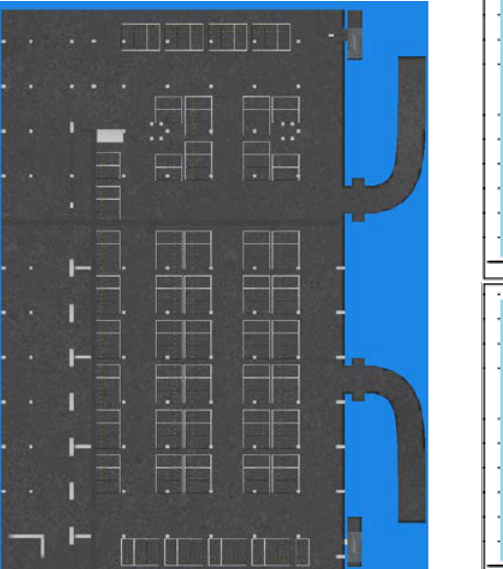
(c) Figure 20. Topology map construction results: ( a ) rough result after road length and connection estimations; ( b ) pathway map after topology modification; ( c ) final pathway map after orientation correction.